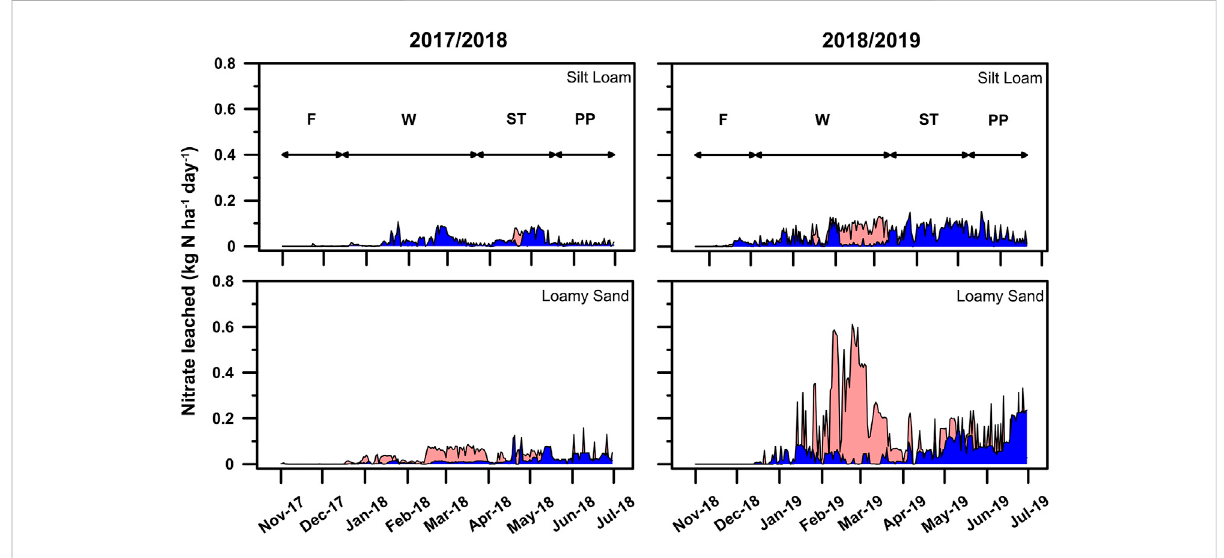
FIGURE 2 Daily nitrate leaching values averaged per heating regime (with/without heating) and soil type (silt loam and loamy sand) for the 2017/2018 and 2018/2019 seasons. Lysimeters without heating are represented by a solid black line and blue shade, and arti fi cially heated lysimeters by a solid line andlightredshade.Blackhorizontallinesdelineatetheanalysisperiods:F,fall;W,winter;ST,spring-thawandPP,post-plantingperiods.Covercrops established and performed poorly in